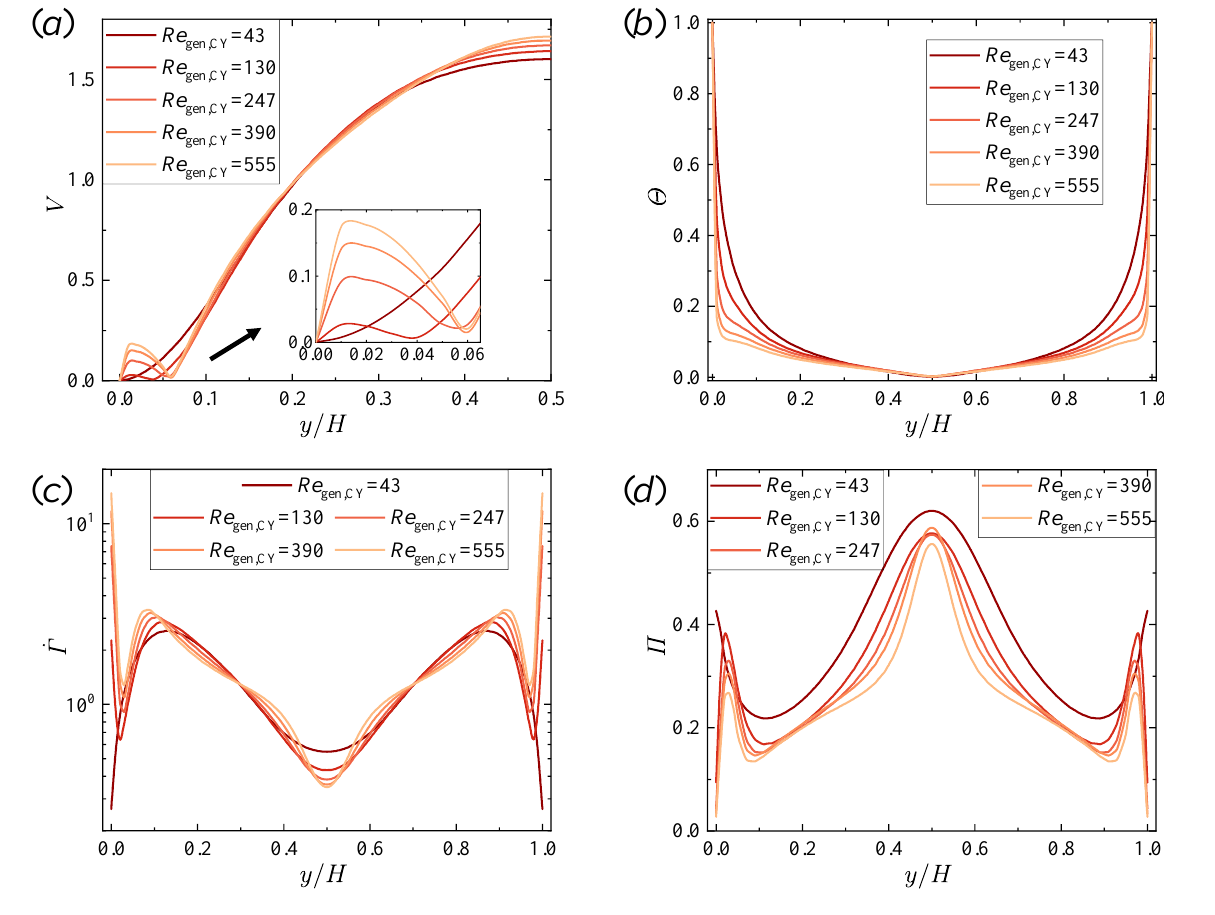
Figure 13. Profiles of the dimensionless ( a ) velocity, ( b ) temperature, ( c ) shear rate and ( d ) viscosity for different Re gen,CY . The wavelength of the sinusoidal corrugation is 2 H , and the wave amplitude is 1/5 H .